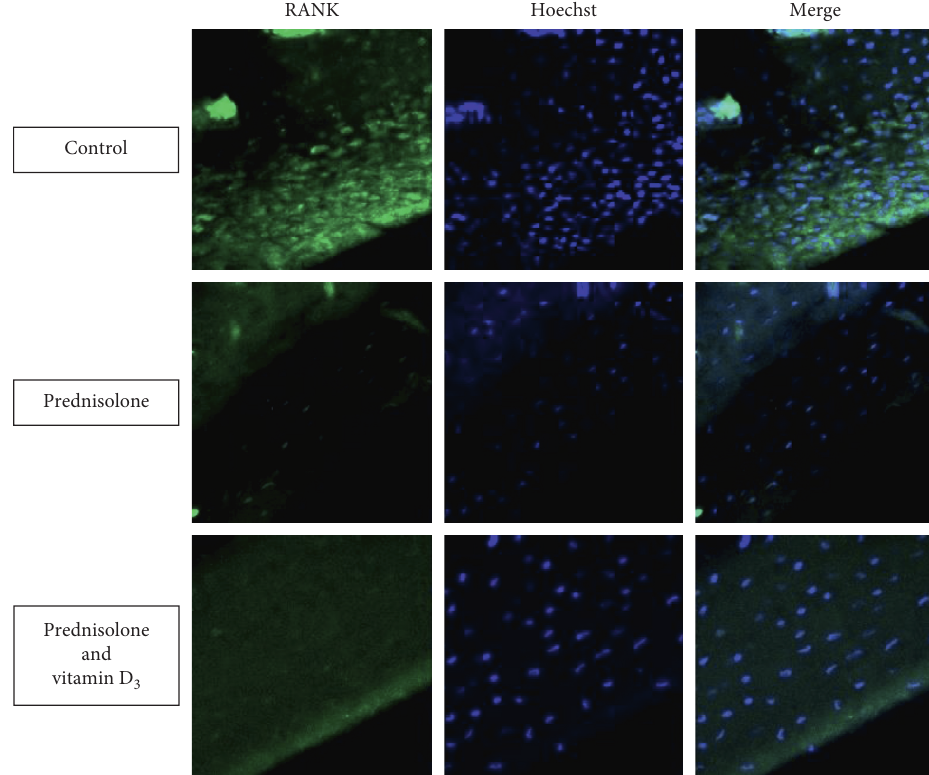
Figure 4: Effects of prednisolone and vitamin D 3 administration on RANK expression in bone tissue. Immunofluorescence staining of rat femur sections with anti-RANK-antibody (400x magnification) was performed in three animal groups: (1) control; (2) pred- nisolone administration; (3) prednisolone and vitamin D 3 administration. All data are obtained in three independent experiments done in